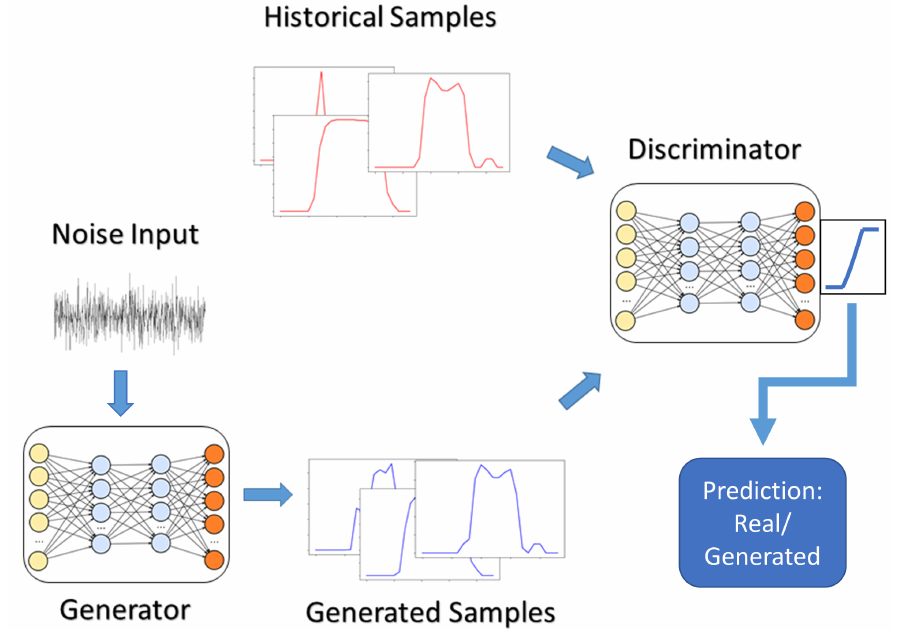
Figure 3. Architecture of generative adversarial networks